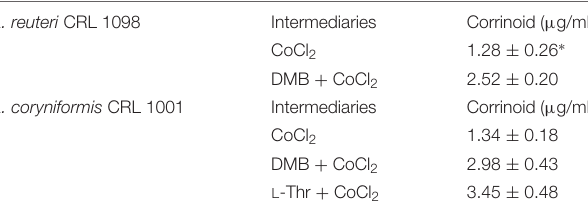
TABLE 2 | Corrinoid compounds quantification by